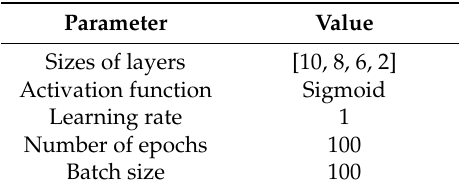
Table 2. Parameter settings of the neural network.